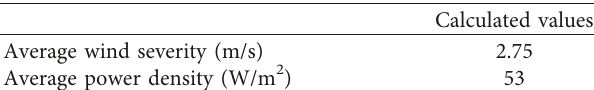
Table 2: Average wind severity and average power density of the region.